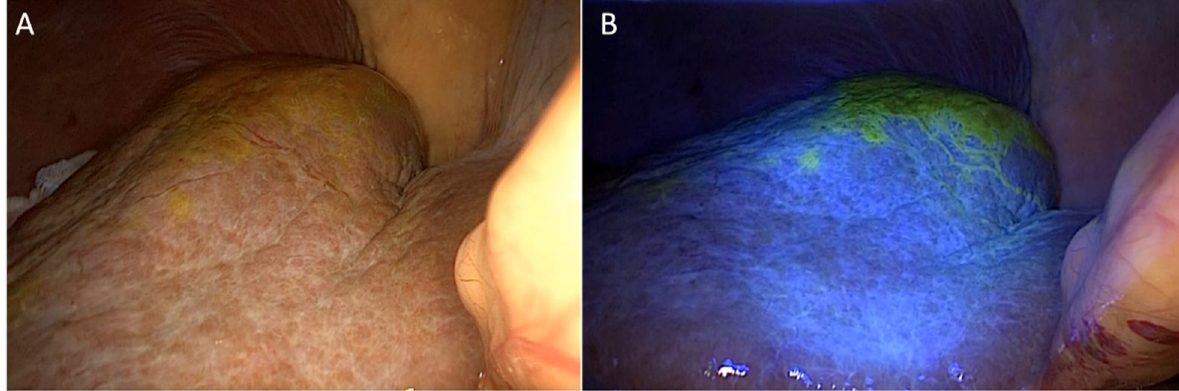
Figure 4. Laparoscopic liver resection using intervention-guided fluorescence imaging technique. ( A ) No fluorescence appeared on the liver surface without blue light. ( B ) Hepatic segment 7 fluoresced under blue light (same case as shown in Figure 1).